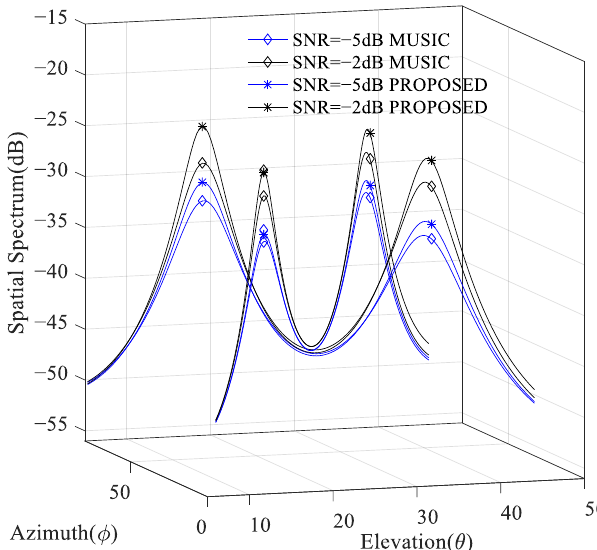
Figure 7. Spatial spectrum versus the input SNR.